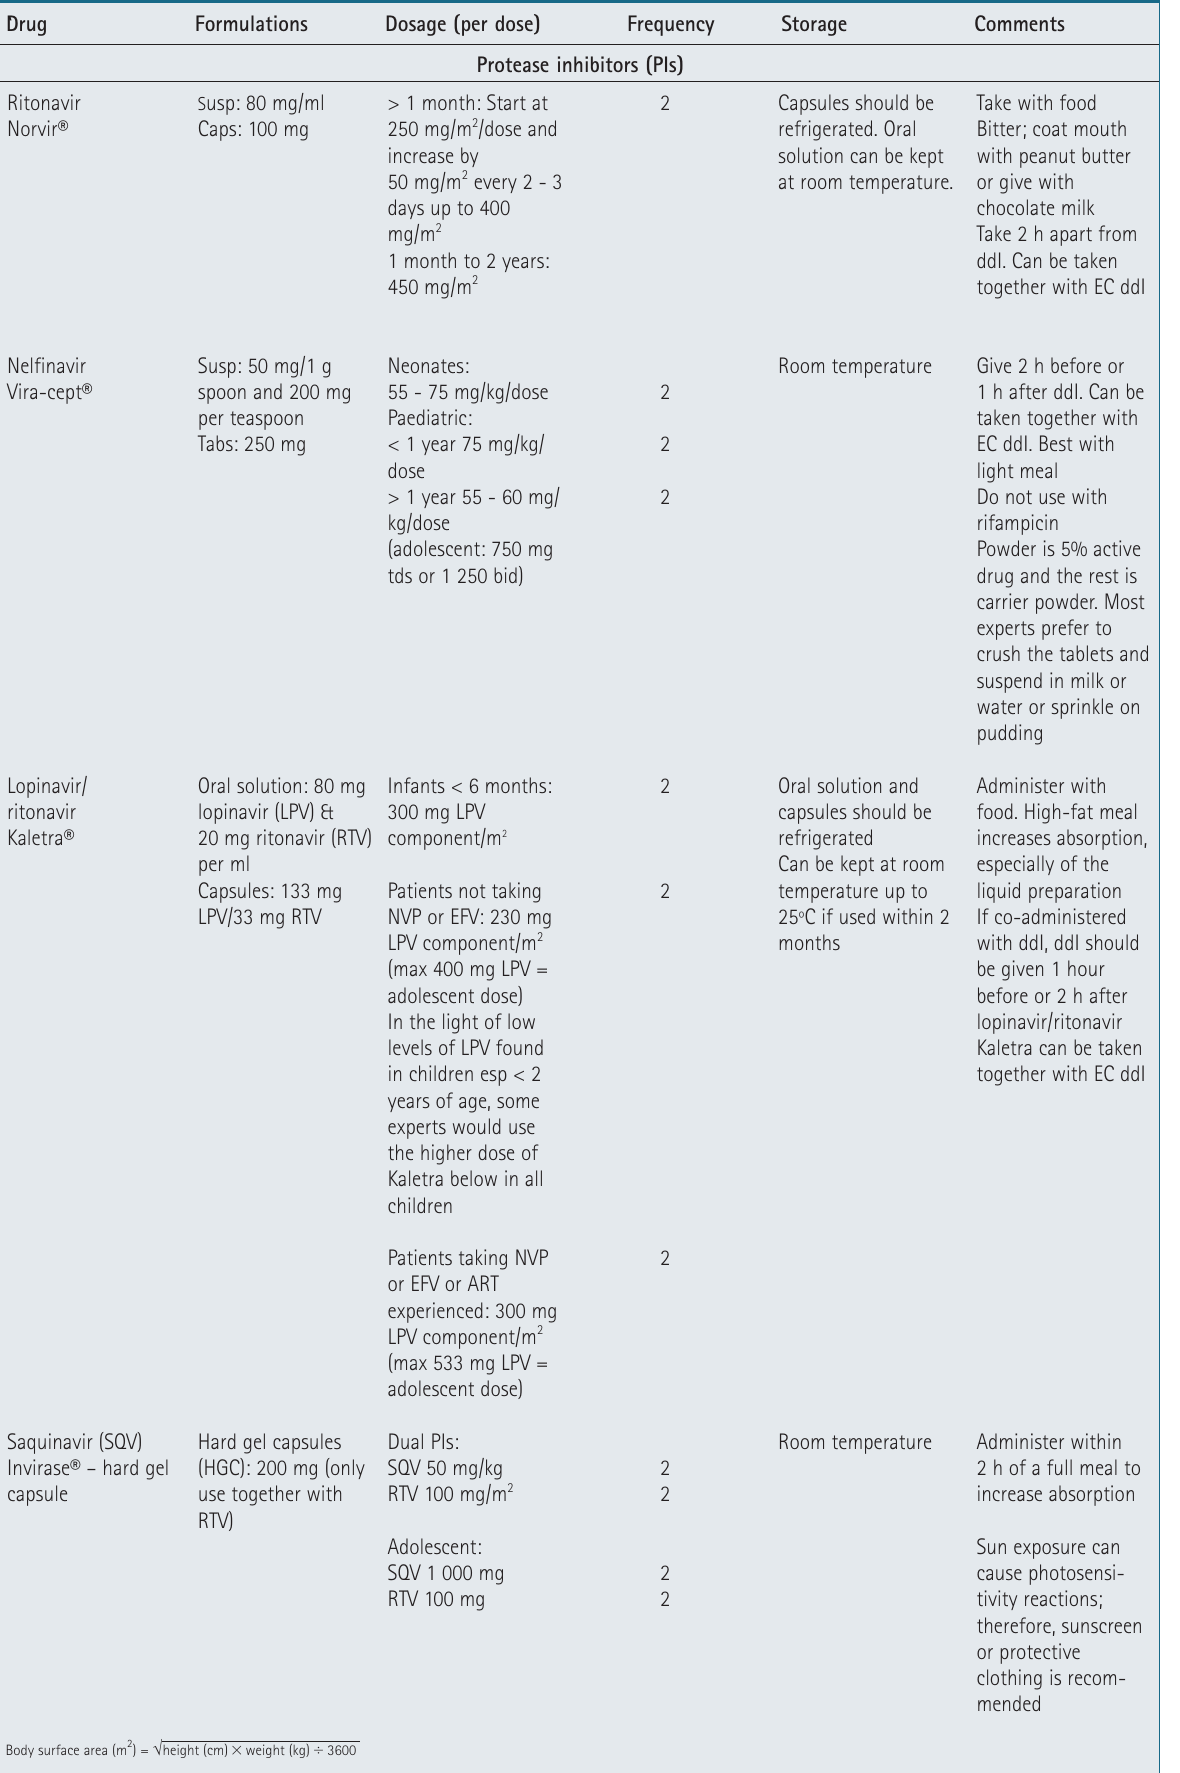
TABLE VIII. DOSAGE AND FREQUENCY OF ARVs IN CHILDREN